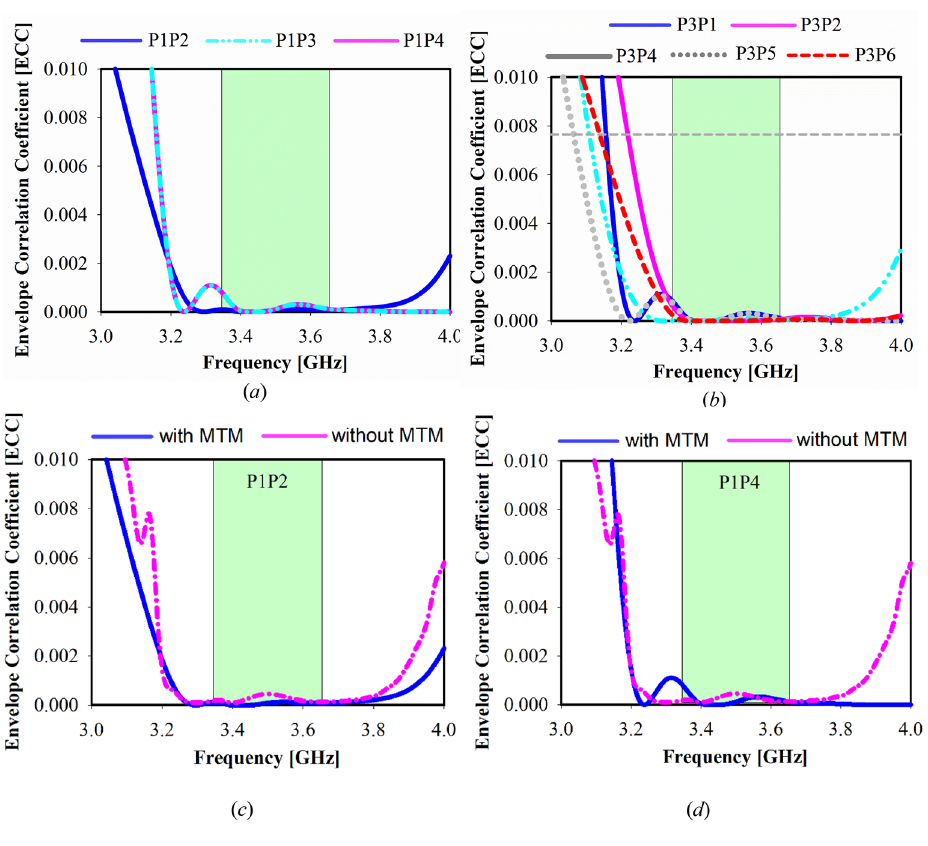
Figure 15. The Envelope correlation coefficient (ECC) of the suggested mMIMO antenna: ( a,b ) Port 1, 2, 3, 4, 5, 6, ( c,d ) Prot 1, 2, 4 with and without MTM.